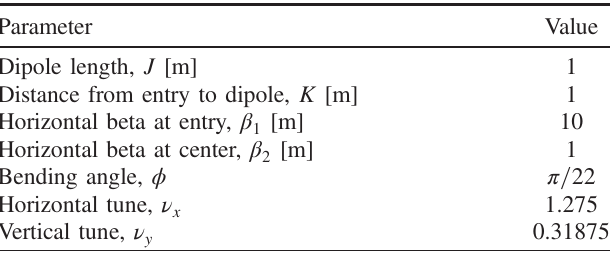
TABLE I. Independent parameters of the double-bend achro- mat